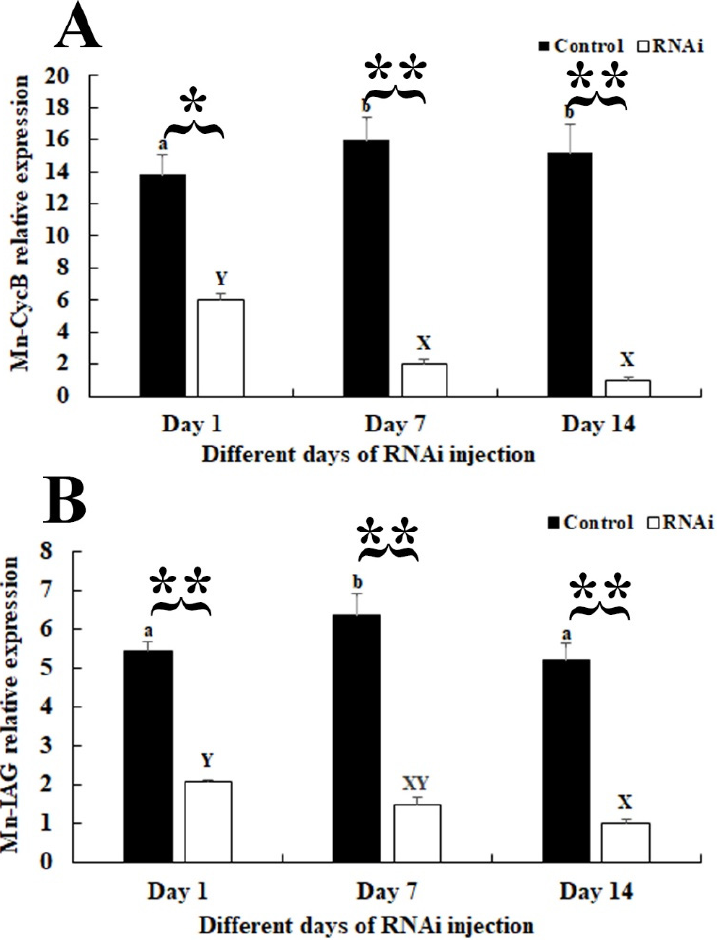
Figure 7. Measurement of Mn-CycB and Mn-IAG expression in the androgenic gland on different days after dsCycB and dsGFP injections. Lowercase letters (a, b) on the bars indicate expression differences between different days after dsGFP injection, and capital letters (X, Y) on the bars indicate expression differences between different days after dsCycB injection (analysis of variance (AVONA)). * p < 0.05 and ** p < 0.01 indicate significant expression differences between the dsGFP - and dsCycB -treated groups on the same day (independent sample t -tests). ( A ) Mn-CycB expression on different days after dsGFP and dsCycB injections. ( B ) Measurement of Mn-IAG expression on different days after dsGFP and dsCycB injections.